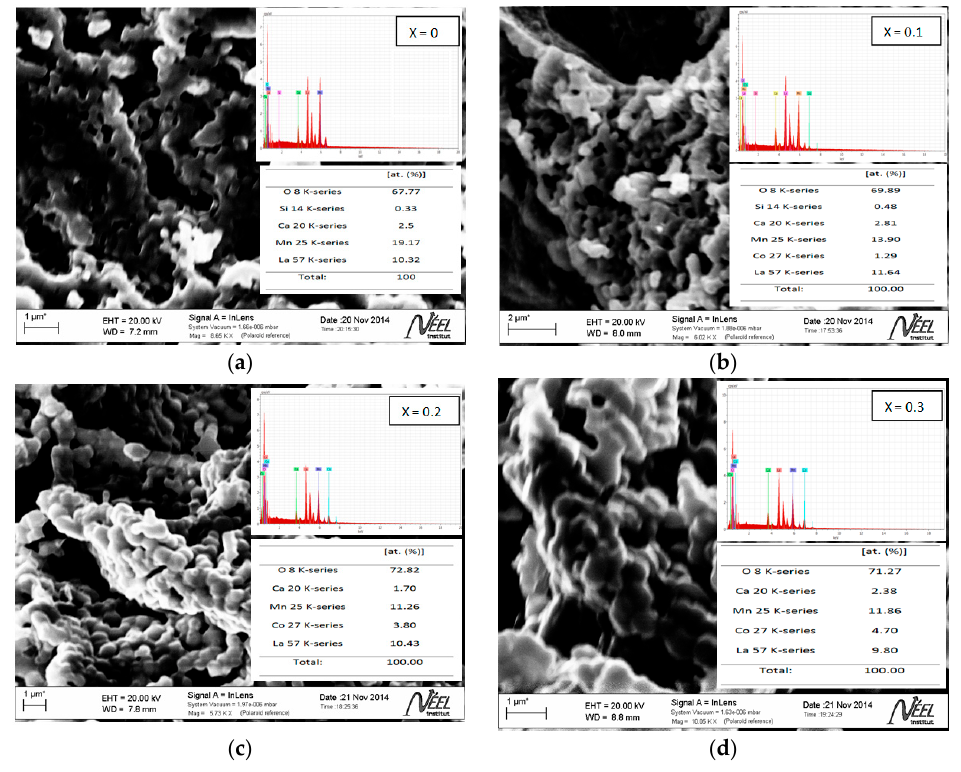
Figure 2. SEM micrographs, EDX and deduced atomic composition of corresponding samples. ( a ) La 0.8 Ca 0.2 MnO 3 ; ( b ) La 0.8 Ca 0.2 Mn 0.9 Co 0.1 O 3 ; ( c ) La 0.8 Ca 0.2 Mn 0.8 Co 0.2 O 3 ; and ( d ) La 0.8 Ca 0.2 Mn 0.7 Co 0.3 O 3 .